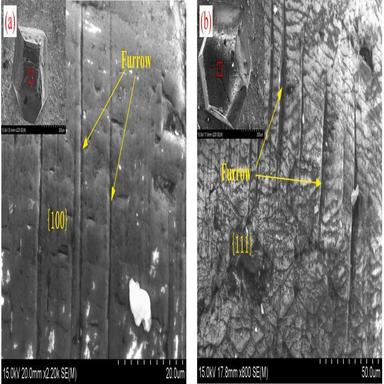
Surface wear of and crystal plane.